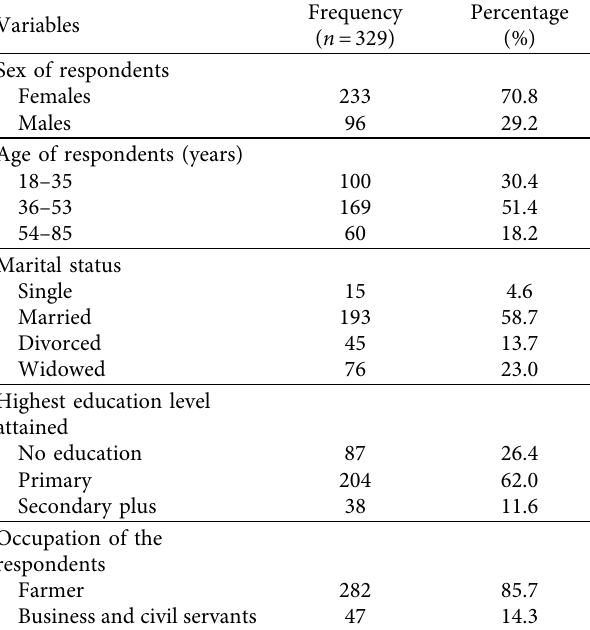
Table 1: Sociodemographic characteristics of the